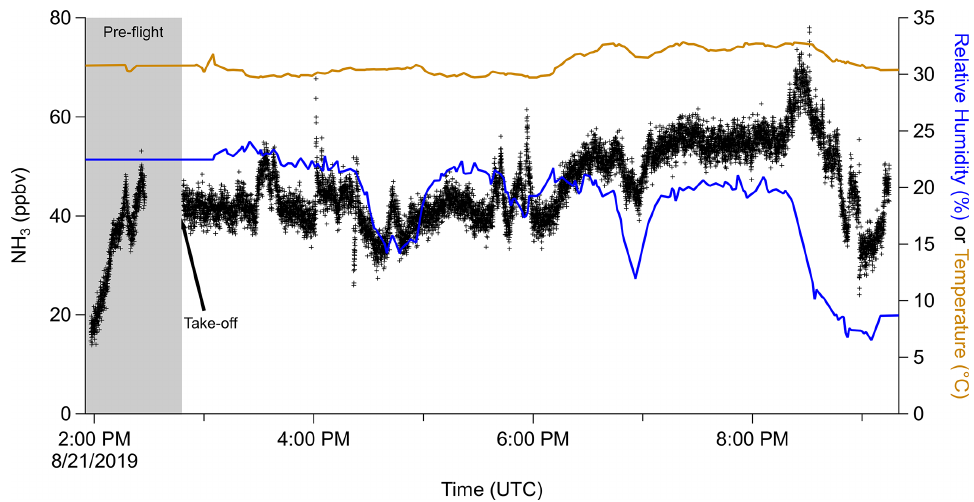
Figure 5. Time series of ammonia (left) and relative humidity and temperature (right) measured inside the cabin of the NASA DC-8 during a flight during the FIREX-AQ campaign. Time spent prior to takeoff is marked with a grey background.